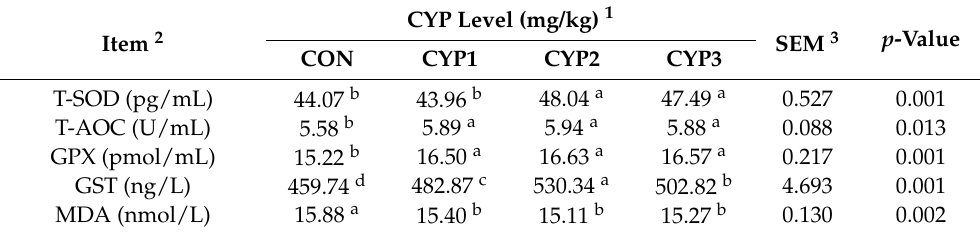
Table 5. Effect of dietary CYP supplementation on the serum antioxidant of